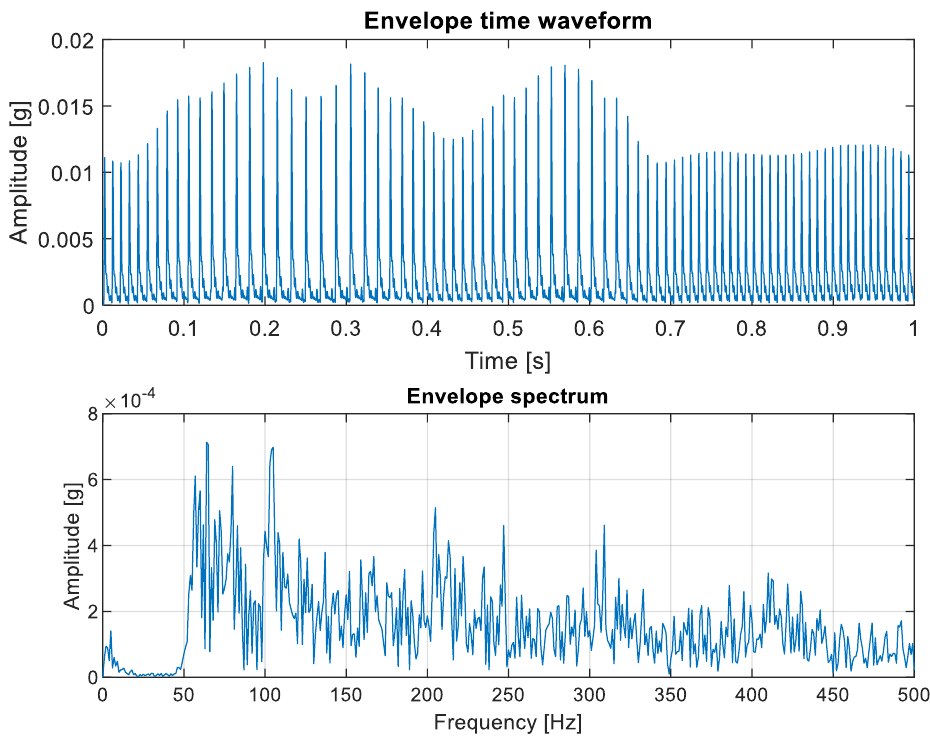
Figure 15. Envelope analysis of the generated signal in the frequency domain.